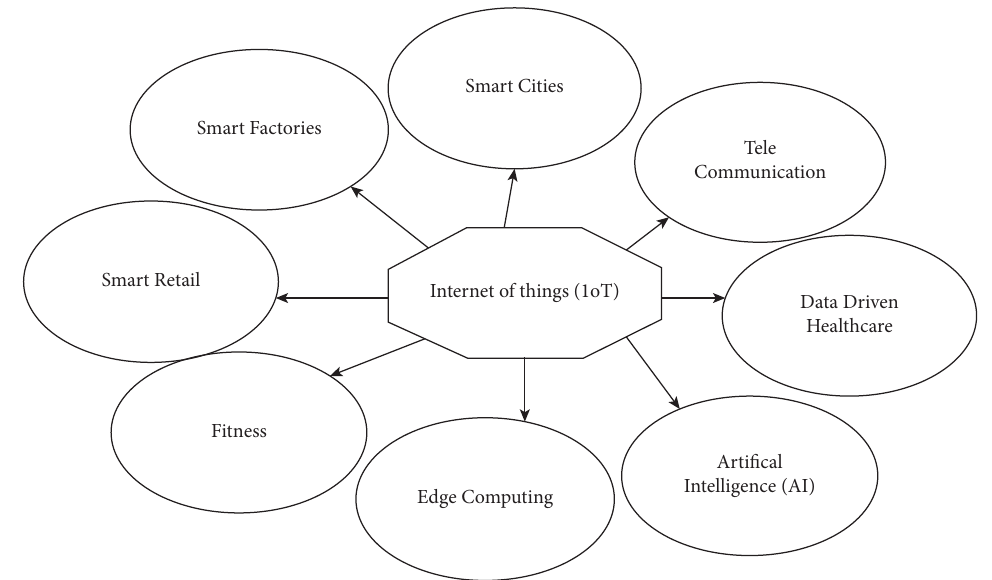
Figure 3: Application of IoT in various